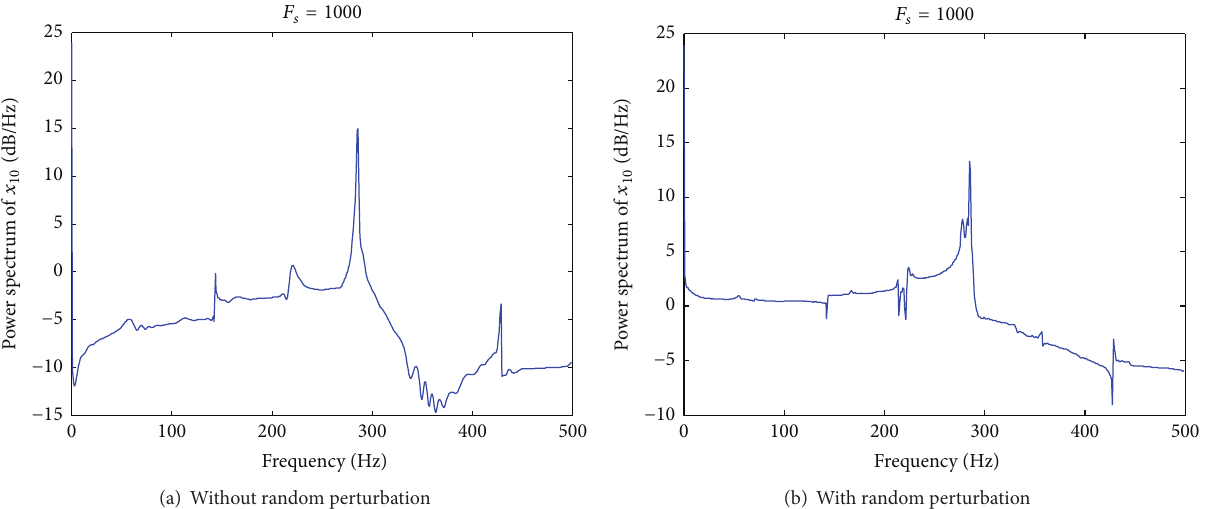
Figure 17: Power spectrum, 𝜔 = 175 .